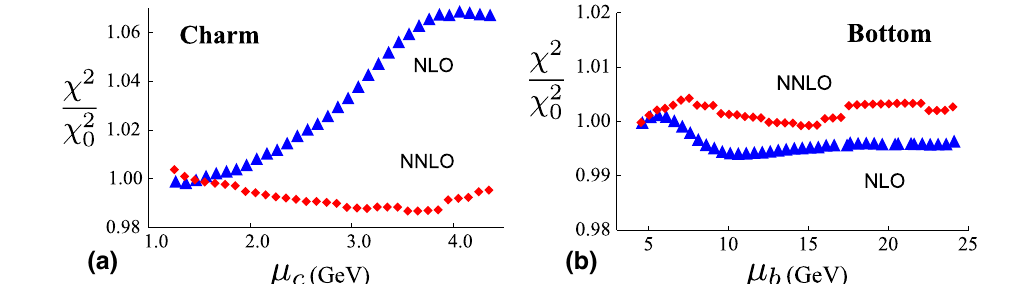
Fig. 9 The ratio ( χ 2 /χ 2 ) of total χ 2 values (all data sets combined) 0 from Figs. 5 and 7, as a function of the a charm and b bottom matching scale μ c , b in GeV. χ 2 is the χ 2 value for μ m equal to the quark mass. 0